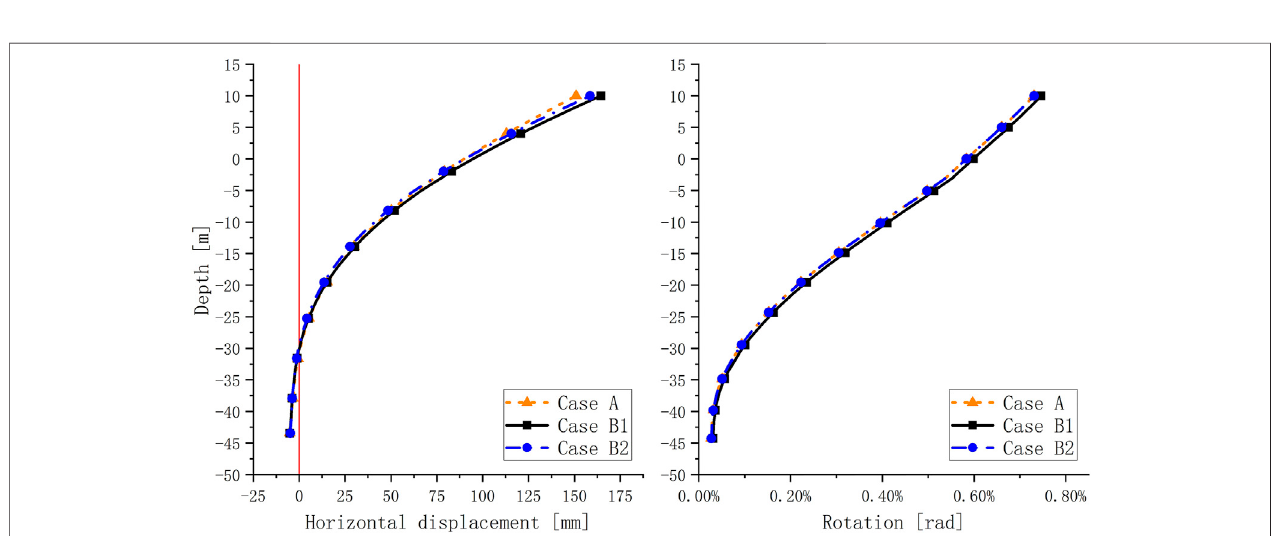
FIGURE 9 | The deformations of the monopile in the ultimate limit state (ULS).